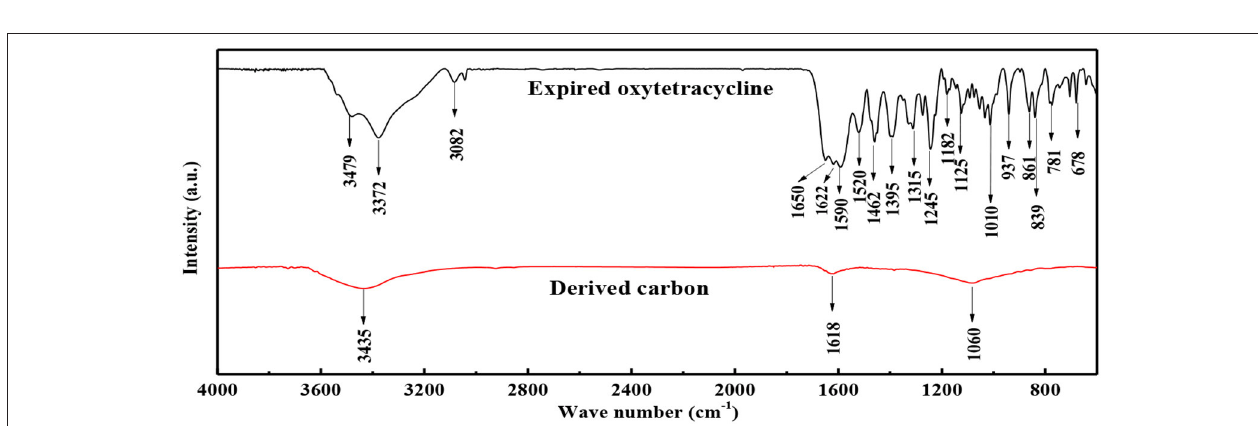
FIGURE 2 | SEM images of (A,B) expired oxytetracycline powders and (D,E) expired-oxytetracycline-derived carbon powders, and EDS spectra of (C) expired oxytetracycline powders and (F) expired-oxytetracycline-derived carbon powders.